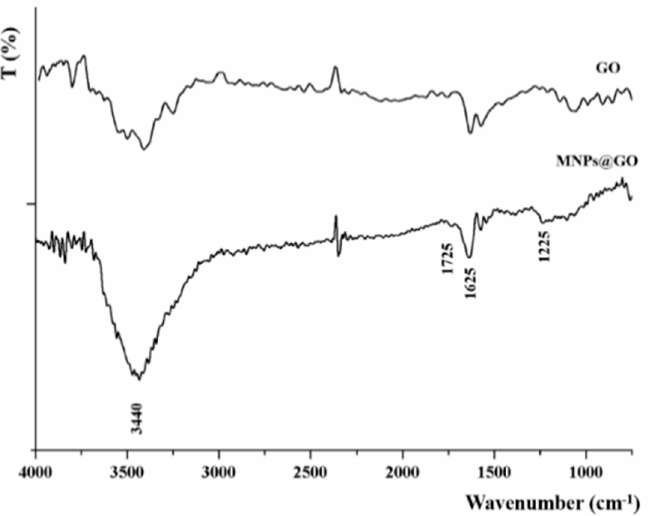
Figure 2. FTIR spectra of GO and MNPs@GO.